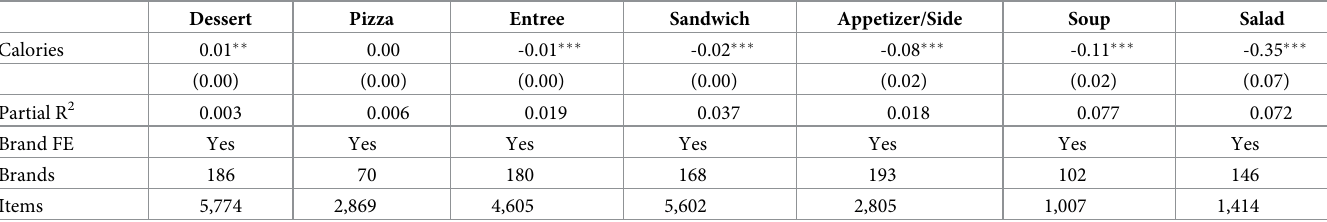
Table 3. Regression of marginal effect of 100 kcal increase on RRR score separate for each main menu category.